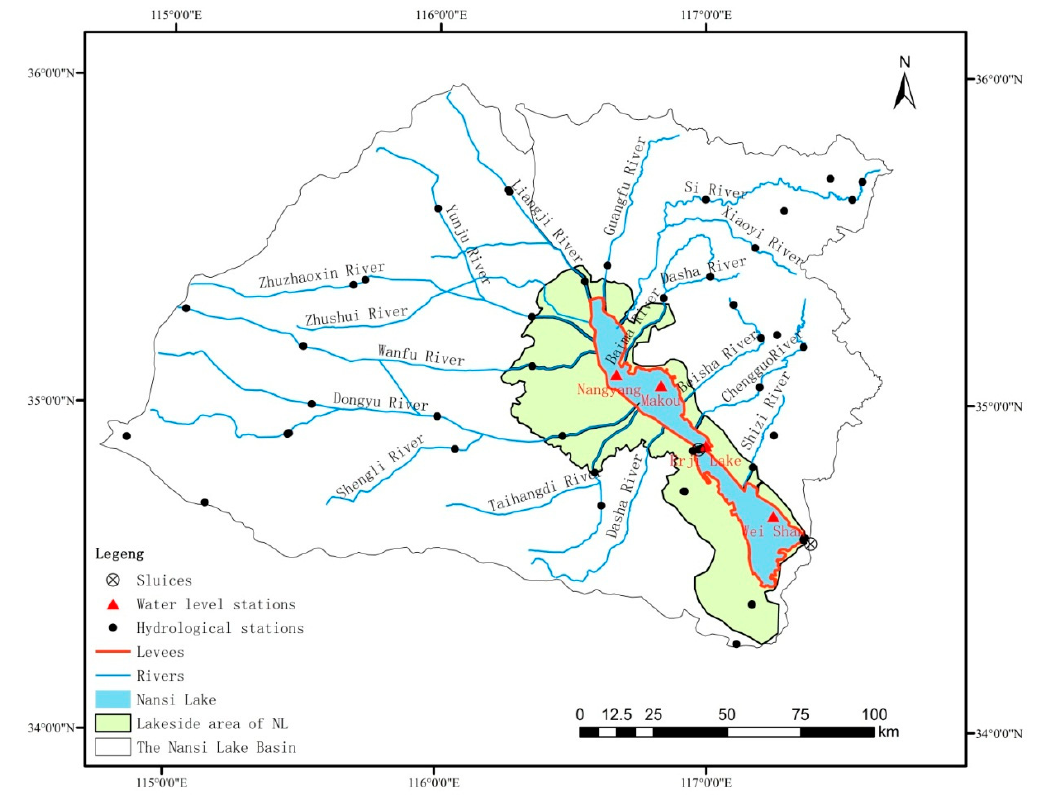
Figure 1. The generalized water system map of the Nansi Lake Basin.